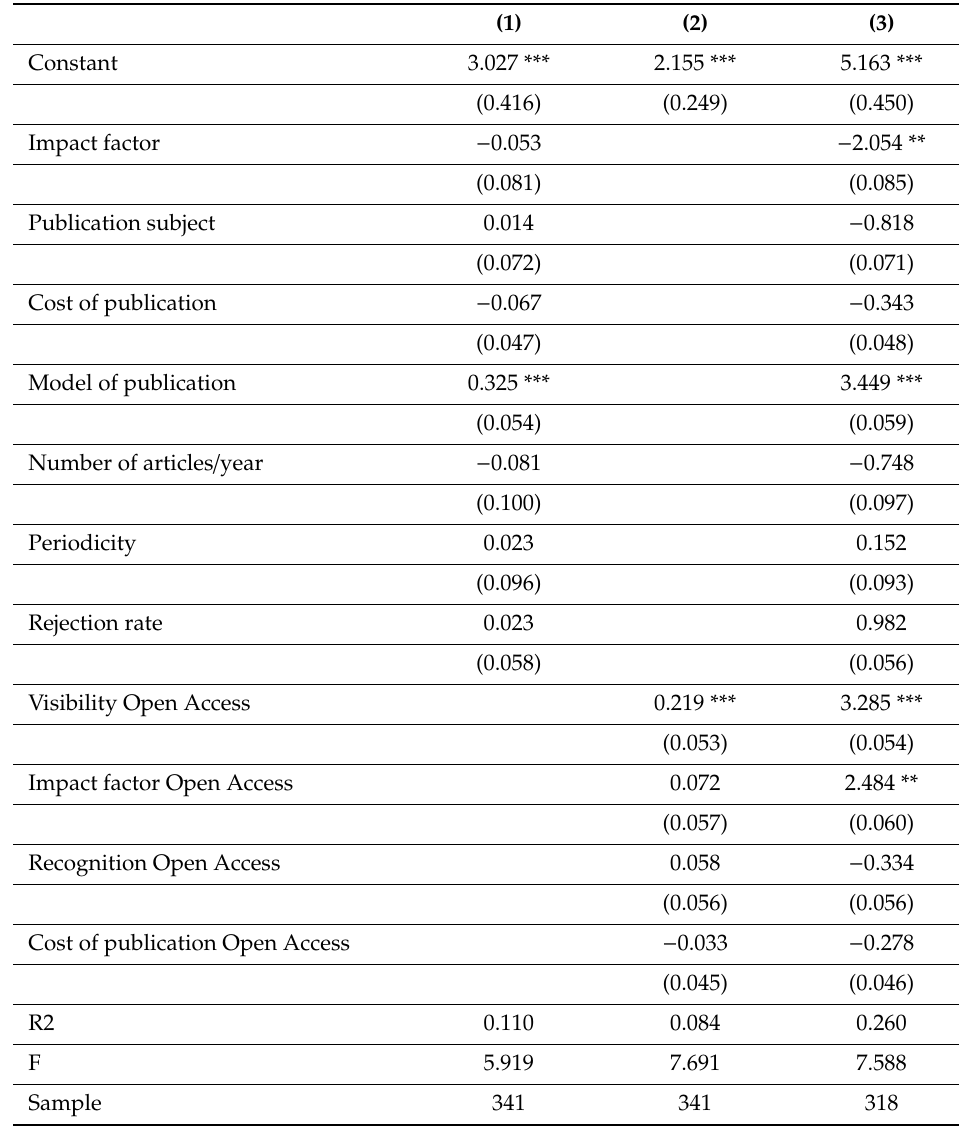
TableA2. DeterminingfactorsoftheevaluationoftheexperienceinOpenAccesspublishing. Regression by Ordinary Least Squares